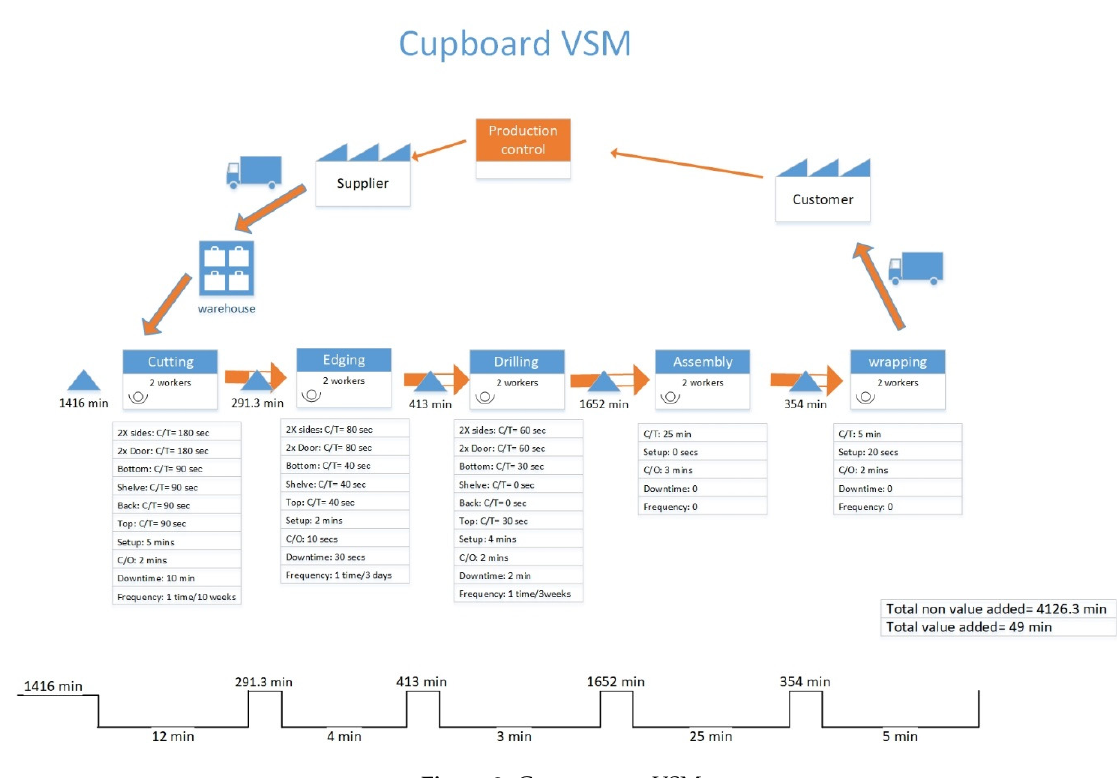
Figure 2. Current state VSM.